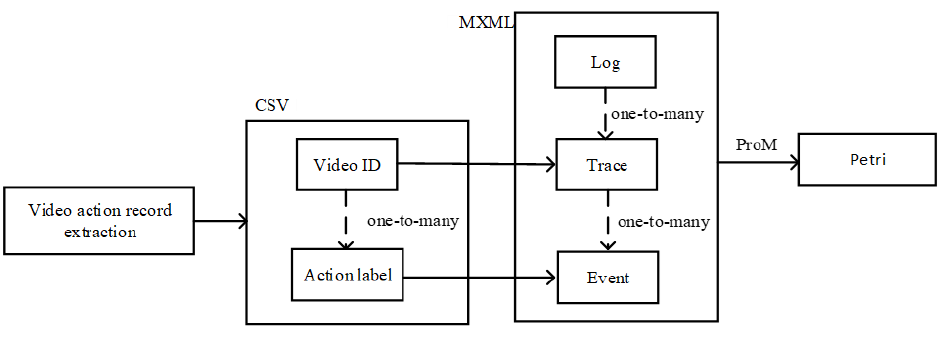
Figure 8. Flow chart of Petri net generation.